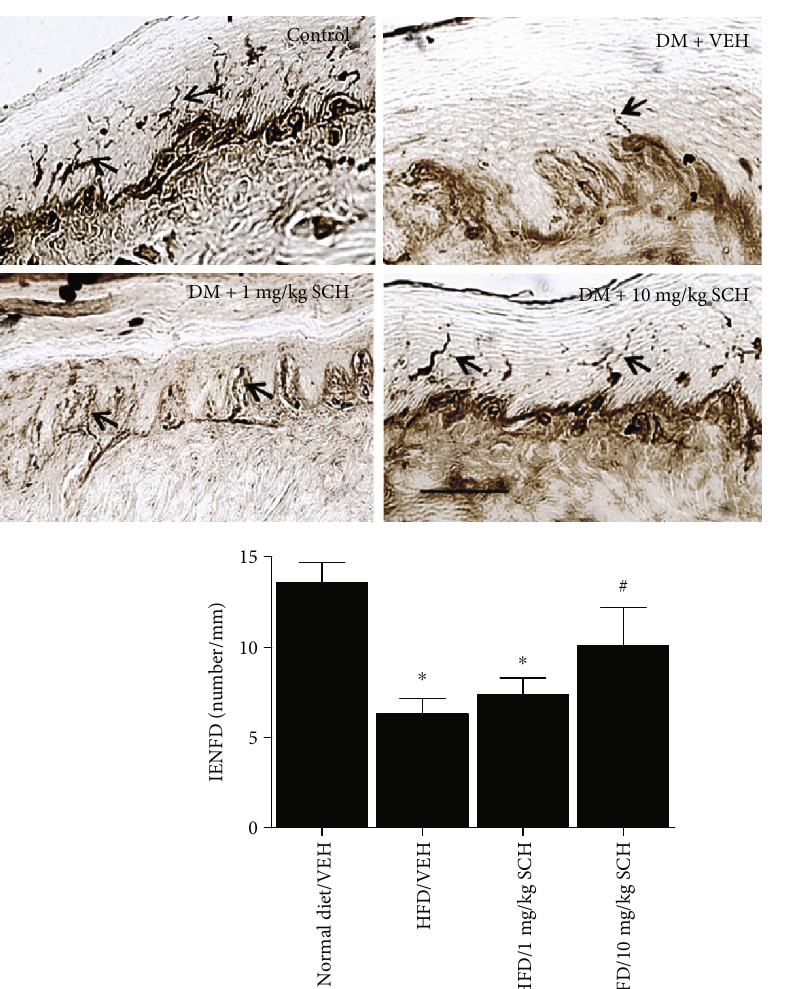
Figure 4: E ff ects of administration of SCH58261 on HFD-induced peripheral neuropathy in mice. Representative photomicrograph of intraepidermal nerve fi ber pro fi les in control and diabetic mice treated with vehicle (VEH) or SCH58261 (SCH), magni fi cation × 200. Arrows indicate the IENFs. Scale bar = 50mm . Values are expressed as the means ± SEM , n = 10 per group. Asterisks represent the signi fi cant di ff erence relative to normal diet control ( p < 0 : 05 ). Pounds represent the signi fi cant di ff erence relative to vehicle ( p < 0 : 05